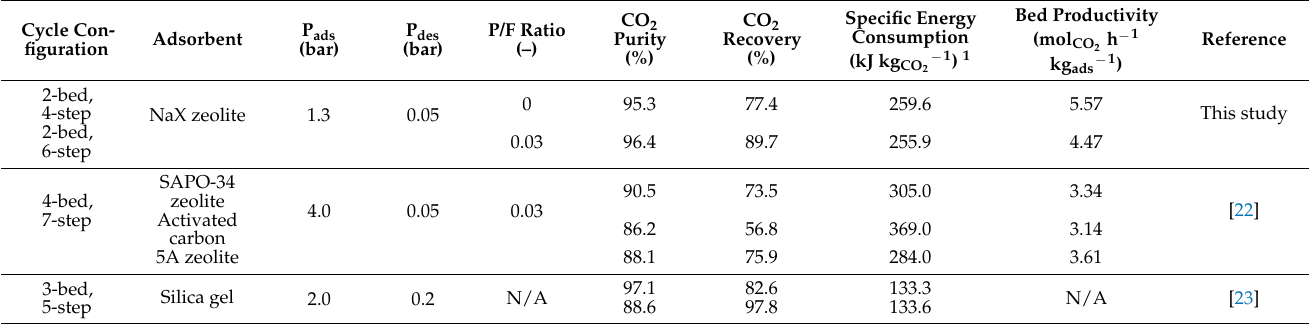
Figure 9. Profiles of ( a ) CO 2 mole fraction and ( b ) other component mole fractions along the dimen- sionless axial bed distance at the end of the adsorption step for the 2-bed, 4-step VPSA (Run 1) and the 2-bed, 6-step VPSA (Run 15). Table 5. Performance comparison of CO 2 capture processes applied to SMR-based hydrogen plant tail gas using VPSA